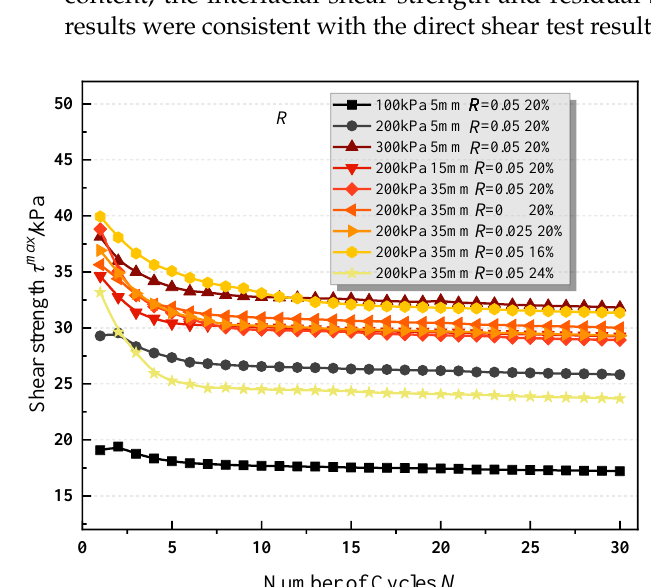
Figure 9. Shear strength of each group.